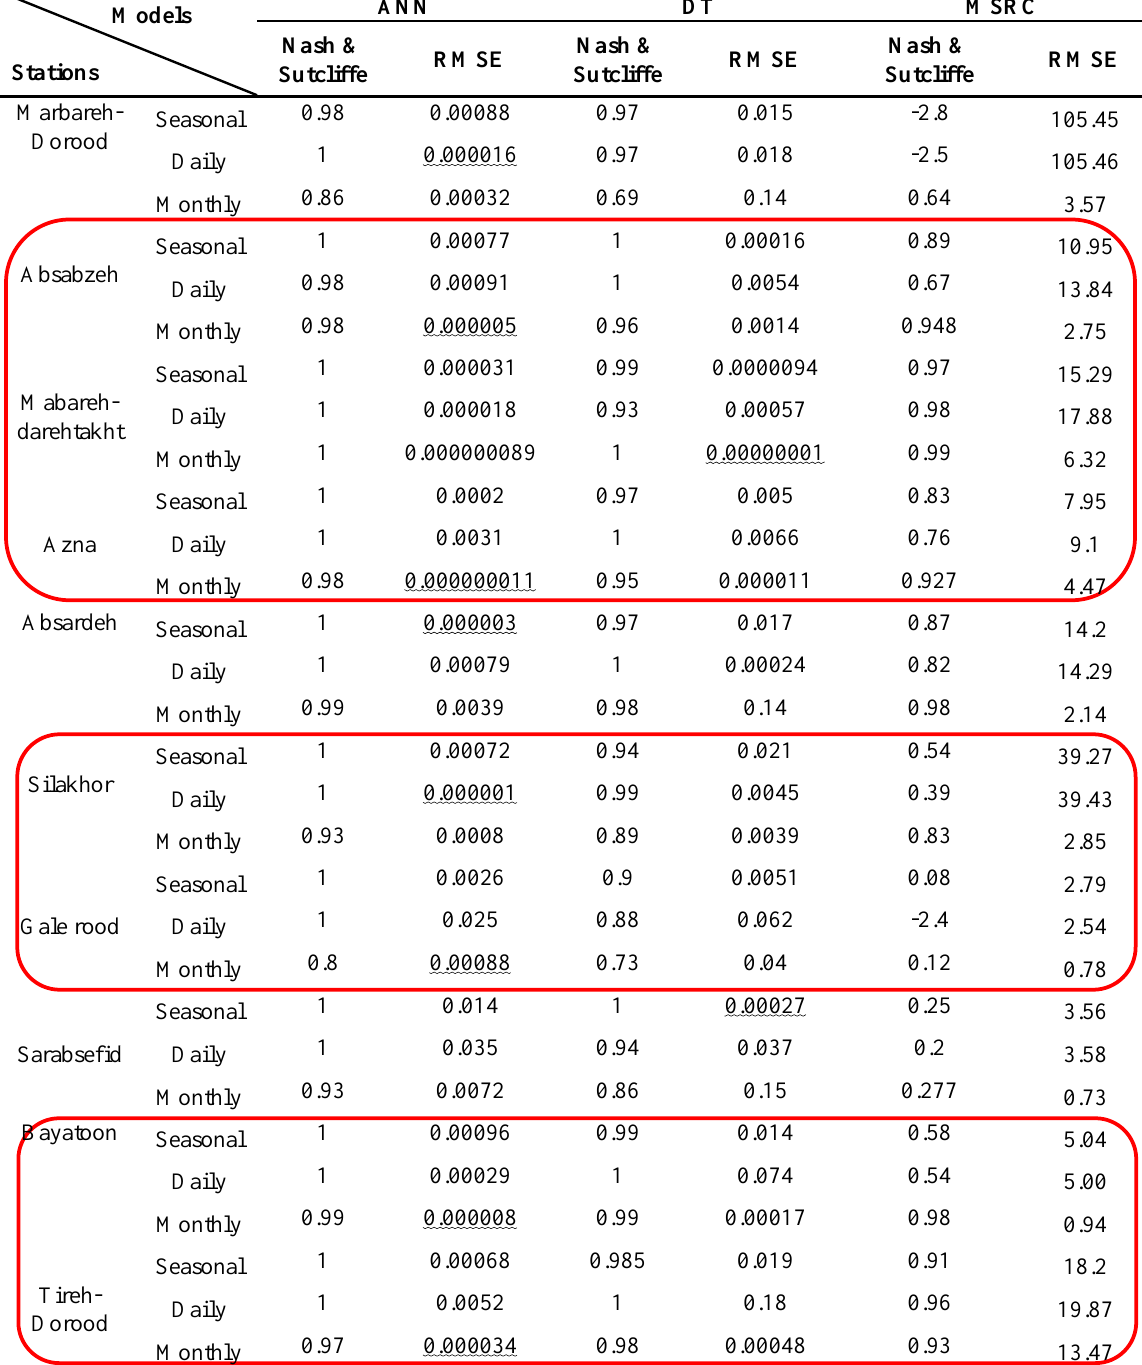
Table 2. Results of estimating suspended sediment by using statistical criteria in the study area